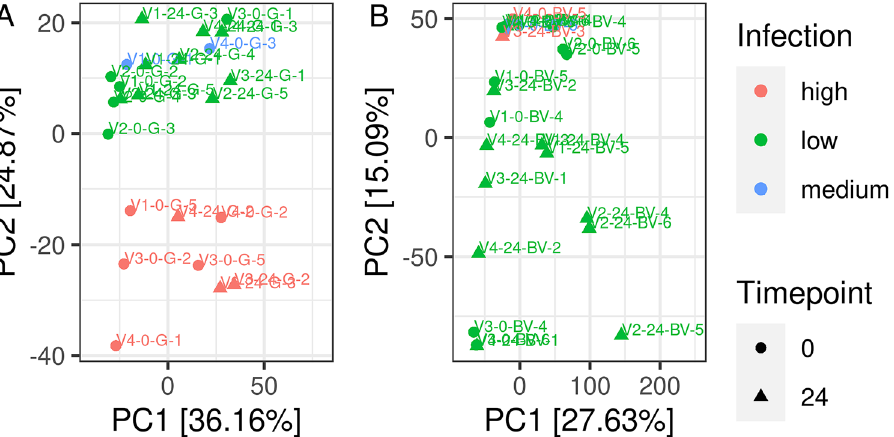
Figure 1. PCA results of ( A ) workers and ( B ) larvae that were highly (red) or moderately (blue) infected or free of infection with Varroa exposed to FA at 0 h (control group, circle) or 24 h (treatment group, triangle).